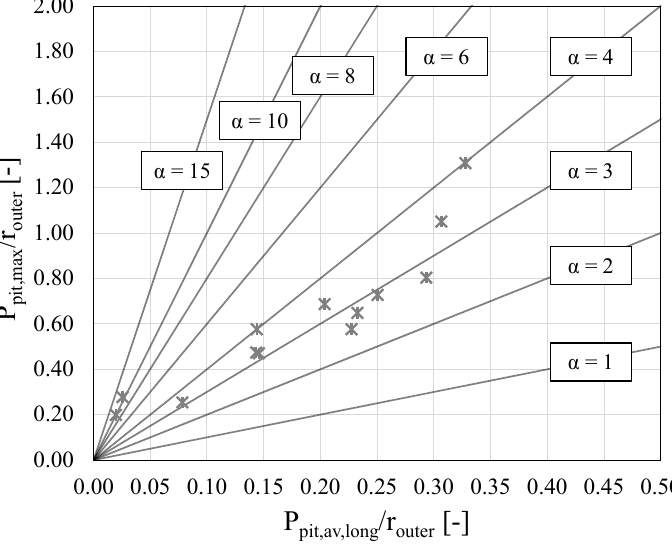
Figure 7. Variation of the longitudinal pitting factor α as a function of P pit,max .